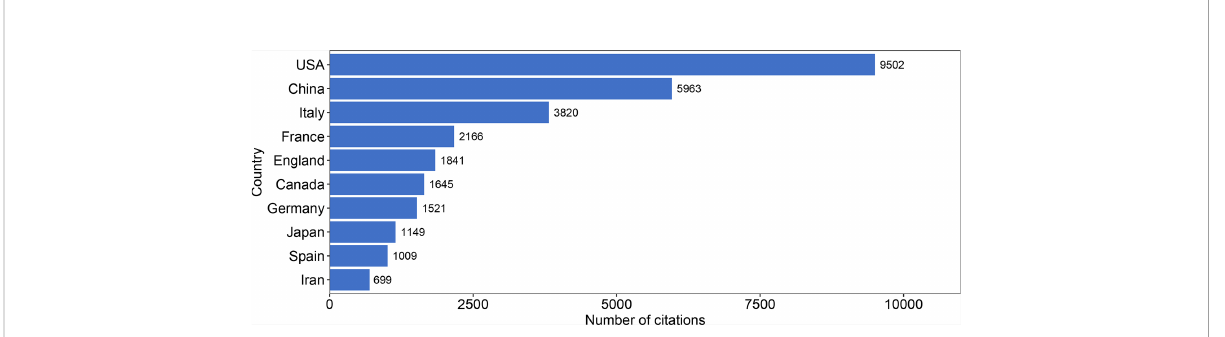
FIGURE 5 Bar graph of the total number of citations from 707 retrieved articles among countries in 2002-2021. The top 10 countries with the highest total number of citations are shown. Each bar represents a country, and the length is positively correlated with the total number of